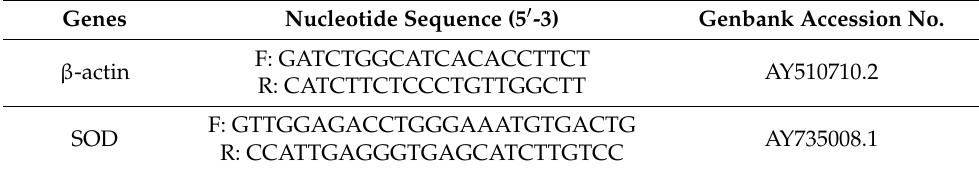
Table 2. Primers pair sequences for real-time